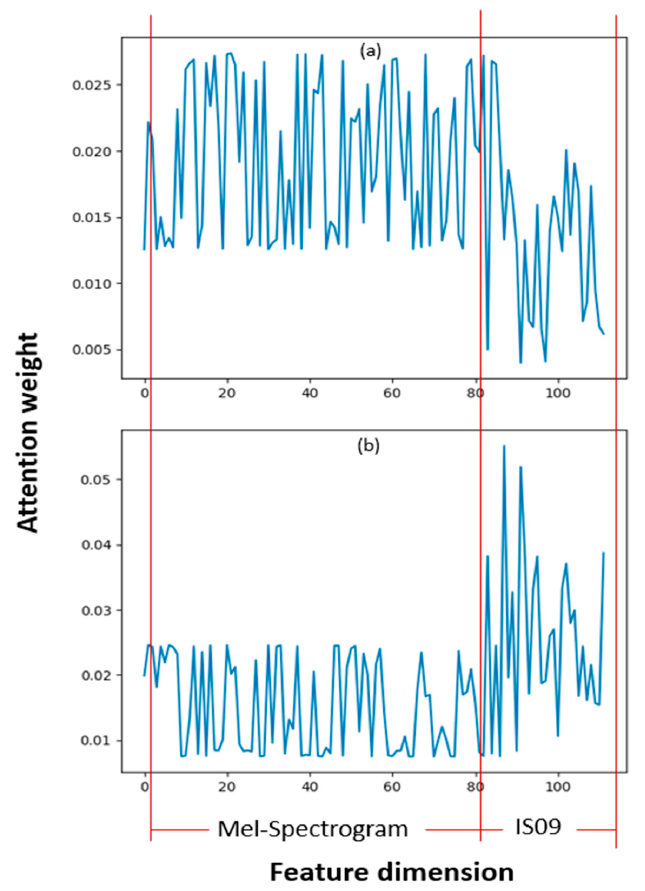
Figure 4. Feature-selected attention-weight visualization. ( a ) Mel spectrogram feature, as weighted by the attention mechanism. ( b ) IS09 feature, as weighted by the attention